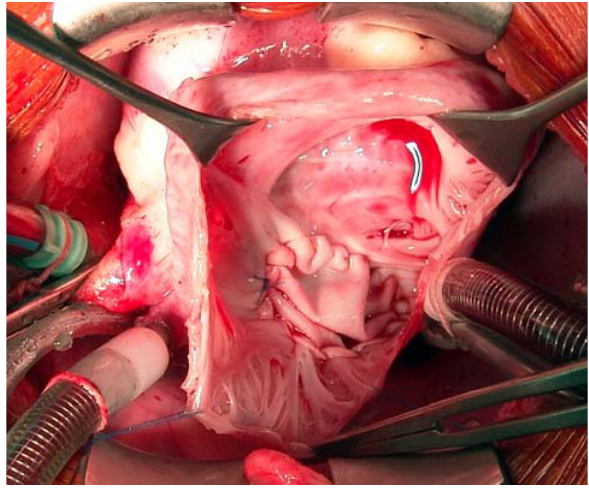
Fig. 3 – Placa de pericárdio bovino redirecionando o fluxo das veias pulmonares direitas após ressecção da lâmina da fossa